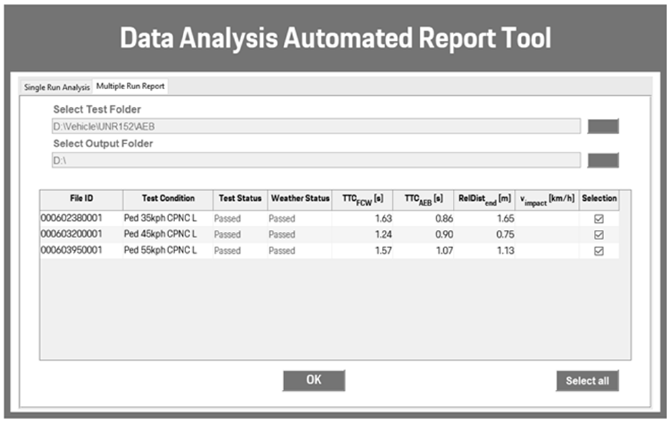
Figure 6. Multiple-run report panel.